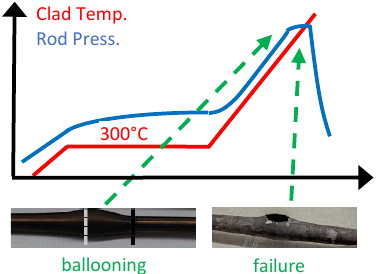
Fig. 1. LOCA sequence and clad expected behaviour.